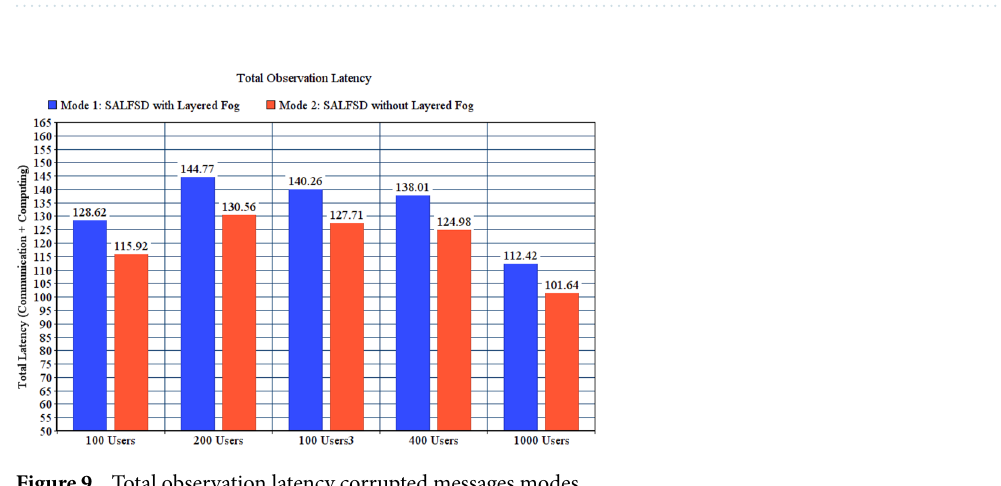
Figure 9. Total observation latency corrupted messages